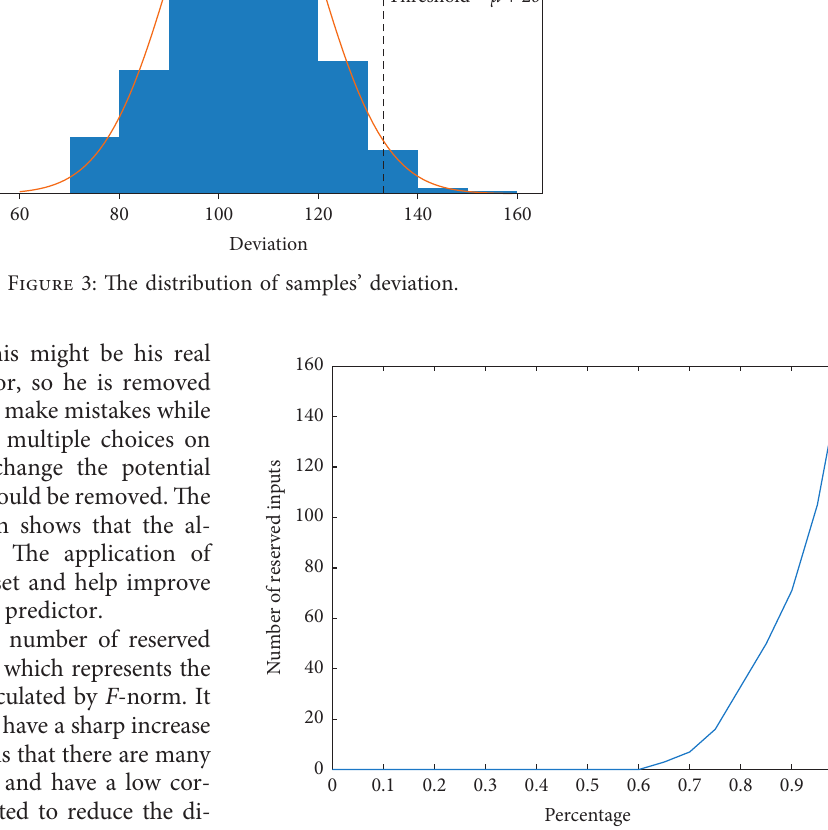
Figure 4: Number of reserved inputs in different